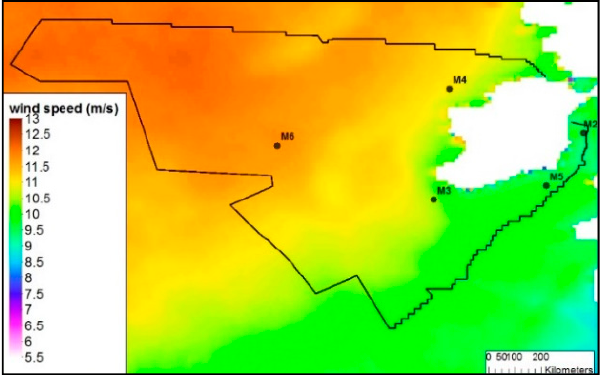
Figure 6. Ireland’s mean offshore wind speed at 80 m above sea level extrapolated with the log law from ASCAT-A and -B observations for the years 2013 to 2016 and ASCAT-A in 2012.